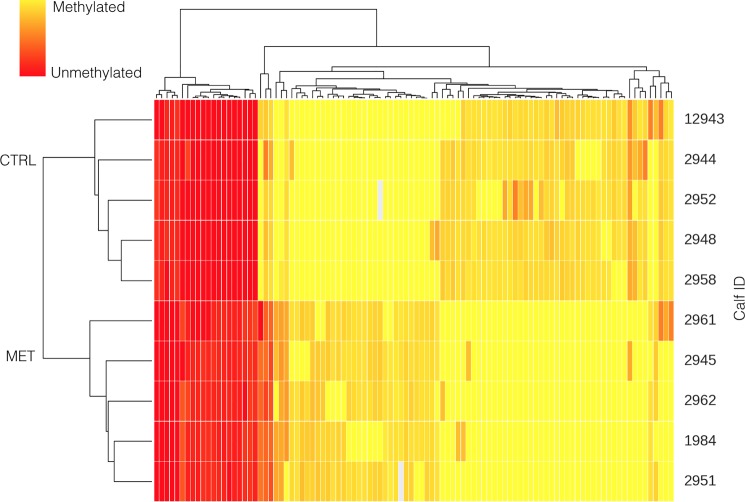
Cluster analysis of CpG sites differentially methylated (p < 0.01) in the offspring as affected by supplementation of methyl donors of their dams during early pregnancy.Control dams received a placebo, whereas lactating MET dams received weekly administrations of 200 mg of folic acid and 20 mg of vitamin B12 and non-lactating MET dams received weekly supplementation of 100 mg of folic acid and 10 mg of vitamin B12.